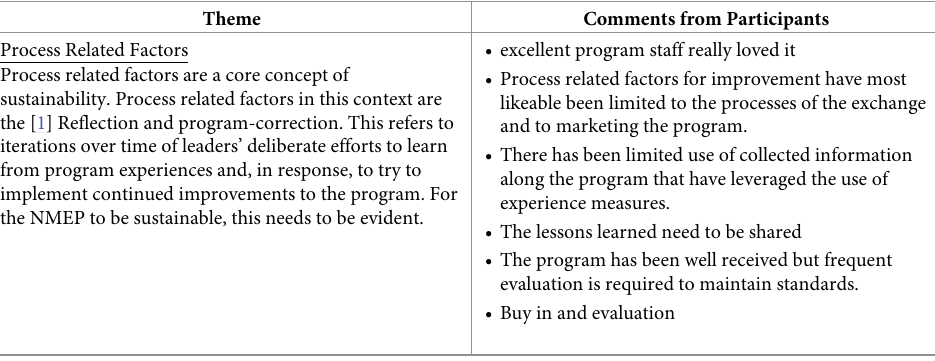
Table 9. Rate the following components regarding the success and sustainability of the NMEP program. Intraclass correlation .763 [good consistency and agreement] ANOVA F = 3.818 (3,18 df), p � 0.05